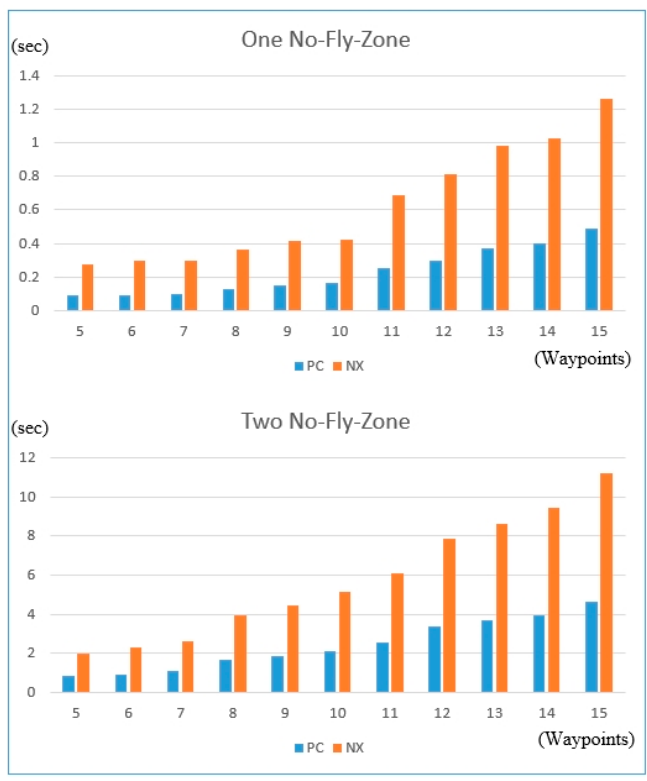
Figure 13. Calculation time of Python on PC and Jetson Xavier NX.